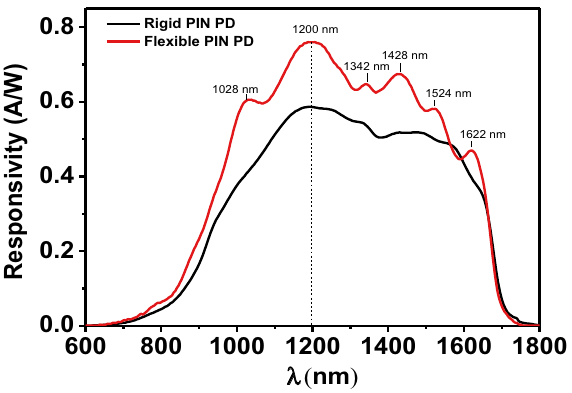
Figure 4. The response spectrum of InGaAs Flexible membrane PD and InGaAs rigid PD at 300